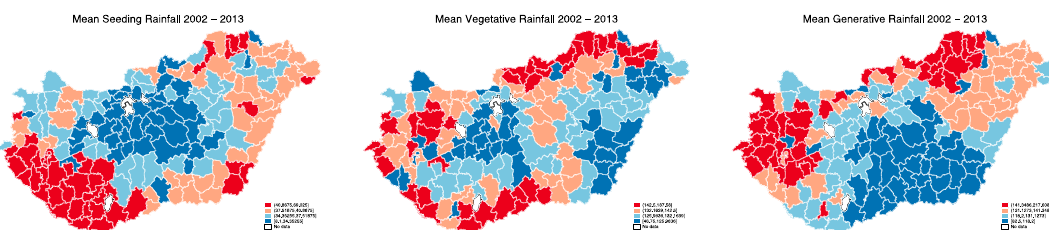
Figure 1. Mean seeding, vegetative and generative temperatures on a Local Administrative Unit Level 1 (LAU1). Source: authors’ calculations based on EU Joint Research Center MARS-AGRI4CAST [22].